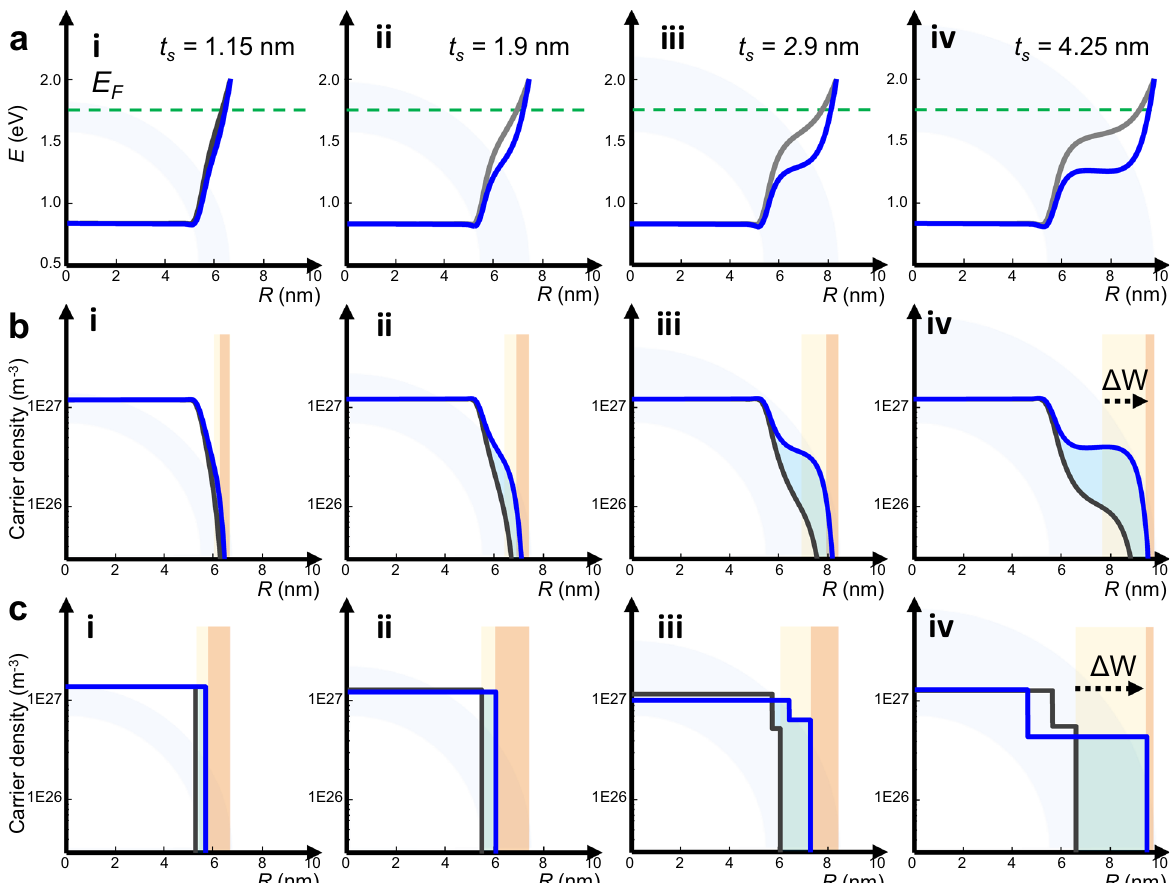
Fig. 3 Band pro fi les and depletion layer modulation via photodoping. a Simulated conduction band pro fi les of core – shell nanocrystals with increasing shell thickness before (black curve) and after (blue curve) the injection of photoelectrons. The light-induced bending of the bands close to the surface of the nanocrystal is the main mechanism responsible for the storage of extra electrons. b Calculated electron density pro fi les of the same nanocrystals. The depletion region W is shaded in orange. The active region ( R active ) of the NC is observed as the region of the NC volume not affected by W . A discrepancy between R active and the structural core ( R core ) and shell ( t s ) dimensions (given in white and light blue in the background) is observed. The largest variations in n e after photodoping occur towards the edge region of the nanocrystal with a signi fi cant rise of carrier density in the shell region (blue shaded regions). Due to photodoping, the active region expands ( Δ R active > 0). Consequently, the depletion layer is progressively suppressed ( Δ W < 0) during the storage of electrons with photodoping (from light orange to dark orange). c Carrier density pro fi les obtained from the fi tting of the experimental data using the multi- layer optical model. The expansion of the active region ( R active ) and W modulations of core – shell NCs of increasing t s upon photodoping are observed similar to from the results from the numerical simulations. The fi lling of the depleted regions with extra electrons is highlighted in blue in panels b and c . The pale blue circle represents the NC